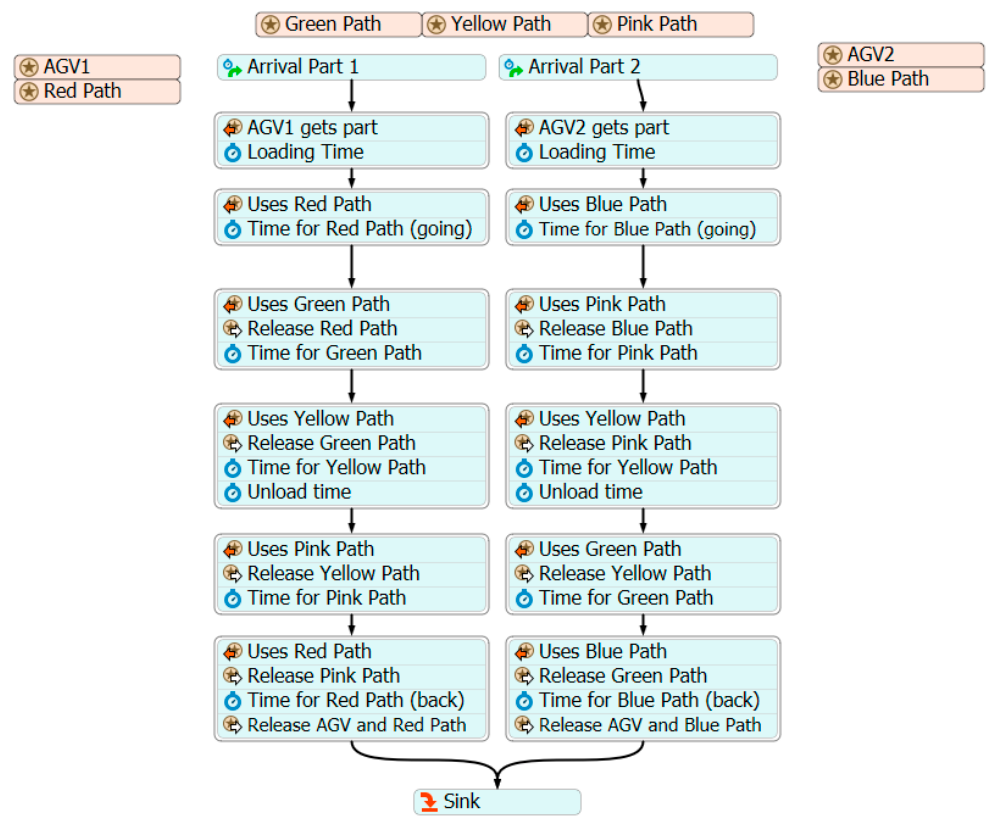
Figure 21. Encoding of both Petri nets in FlexSim. The original case (possible deadlock).